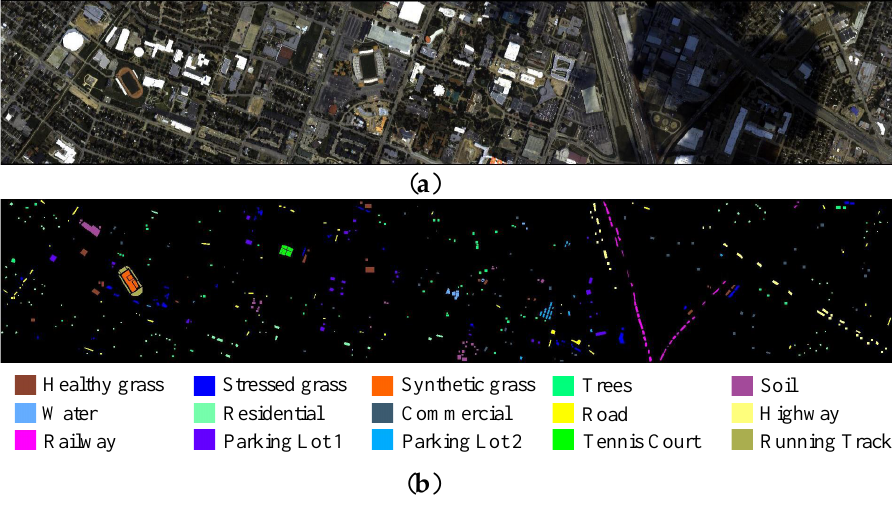
Figure 6. Houston dataset. ( a ) Three-band false-color image. ( b ) Ground truth-map reference. Table 4. Houston dataset: Number of training and test